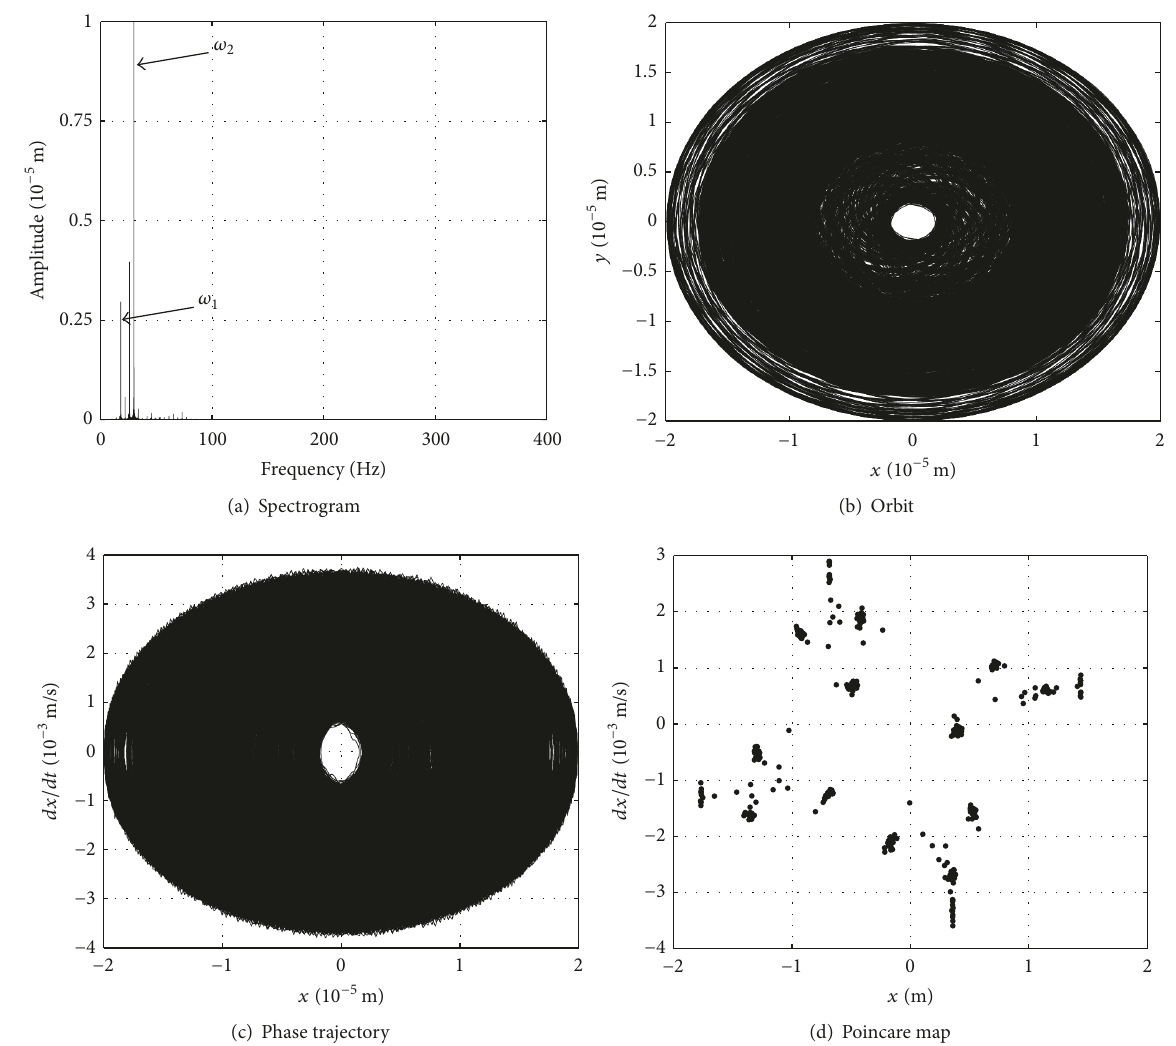
Figure 13: Response analysis of disk 2: 𝜔 1 = 114 rad / s and 𝜆 = 1.65